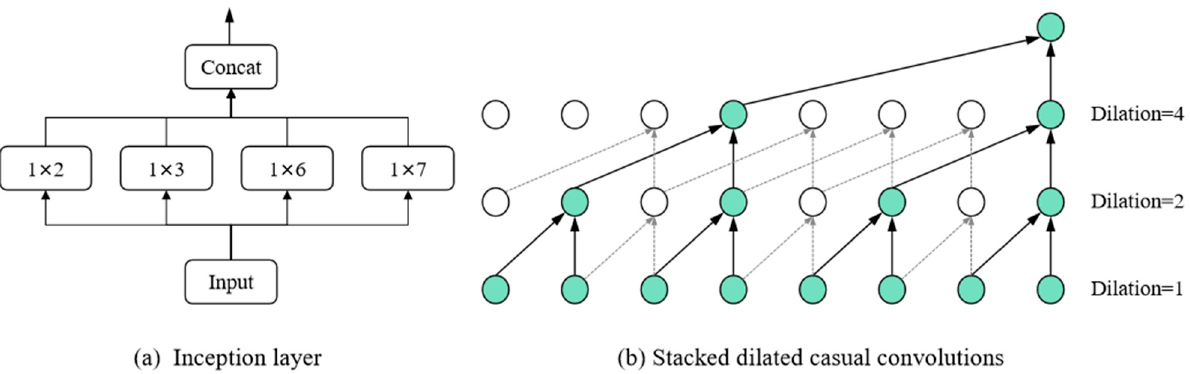
Figure 3. ( a ) Inception layer. Multiple convolution kernels are used simultaneously in each layer for convolution operations. ( b ) Dilated casual convolutions with kernel size 2. With a dilation factor d, it picks inputs every d step.